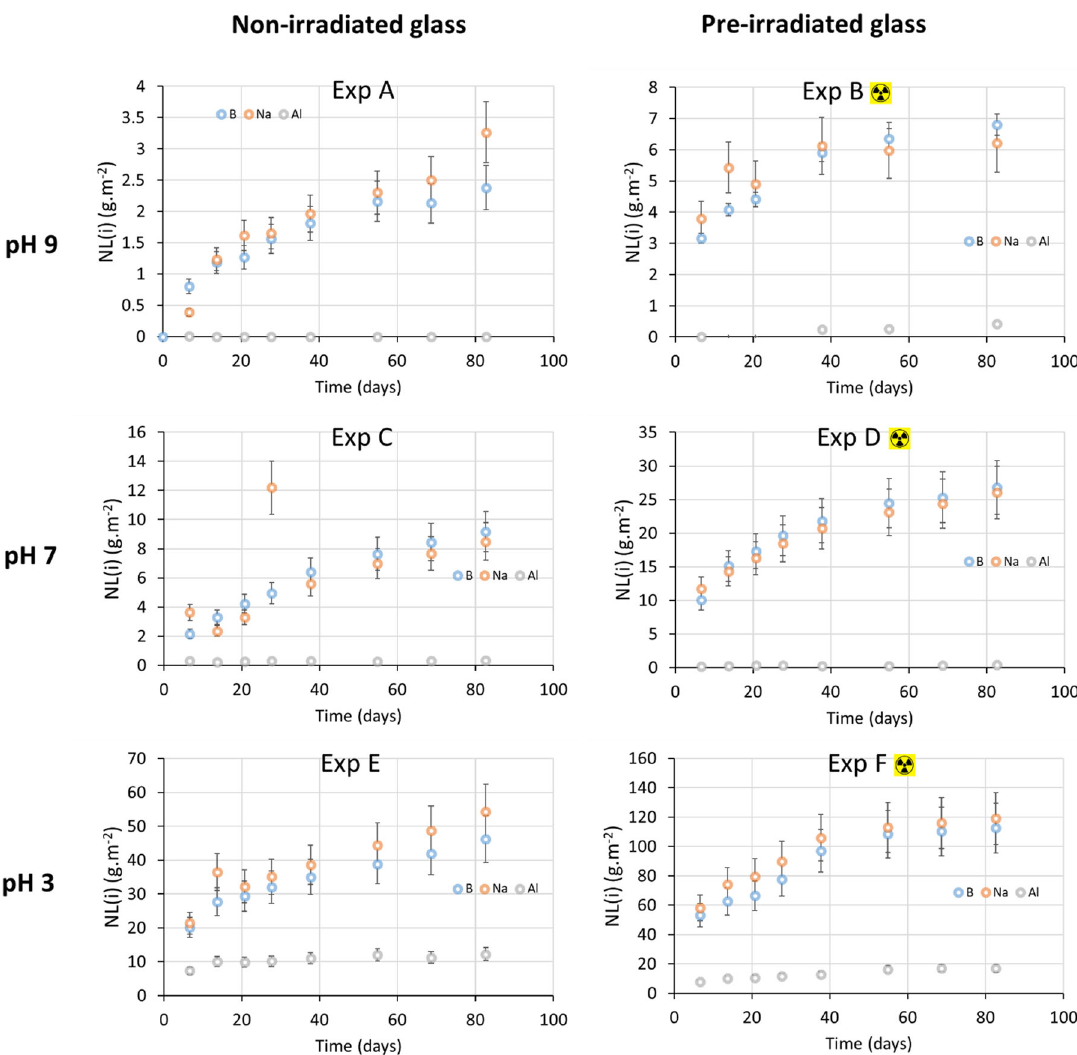
Fig. 4 Normalised mass losses of B, Na, and Al as a function of time for the six experiments.